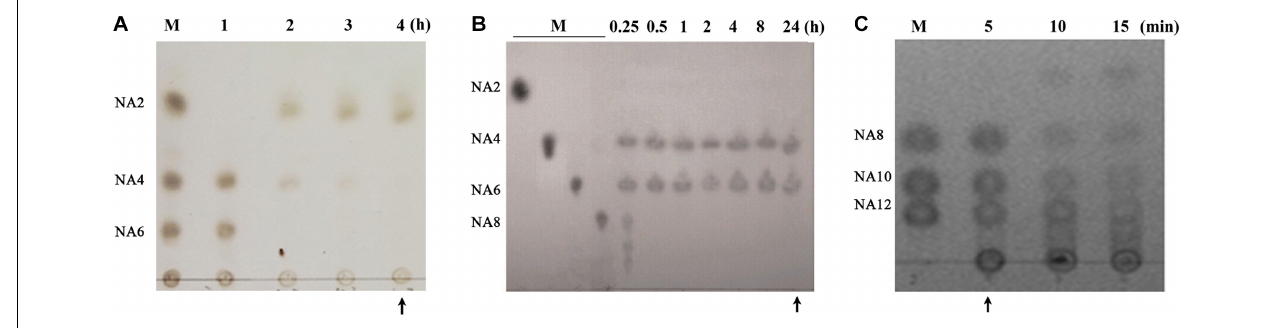
FIGURE 1 | Preparation of algal oligosaccharide (AOS) with varying DP from agar. (A) Preparation of AOS (DP2) by enzymatic degradation of AOS (DP4–6) with Aga2660. (B) Preparation of AOS (DP4–6) by enzymatic degradation of agar with Aga4383. This picture is adapted from the study of Hou et al. (2015). (C) Preparation of AOS (DP8–12) by enzymatic degradation of agar with Aga2133. M, agaroligosaccharide markers; NA2, neoagarobiose; NA4, neoagarotetraose; NA6, neoagarohexaose; NA8, neoagarooctaose; NA10, neoagarodecaose; NA12, neoagarododecaose. The hydrolysate indicated with an arrow in each thin-layer chromatography plate was purified and used in the following experiments.